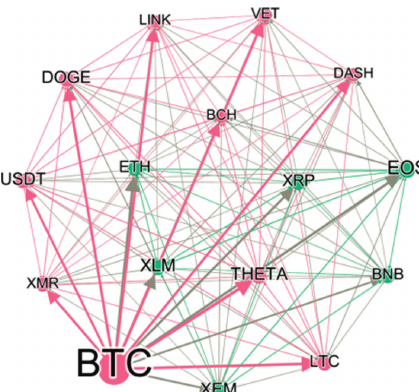
Figure 35: Risk spillover under R1.